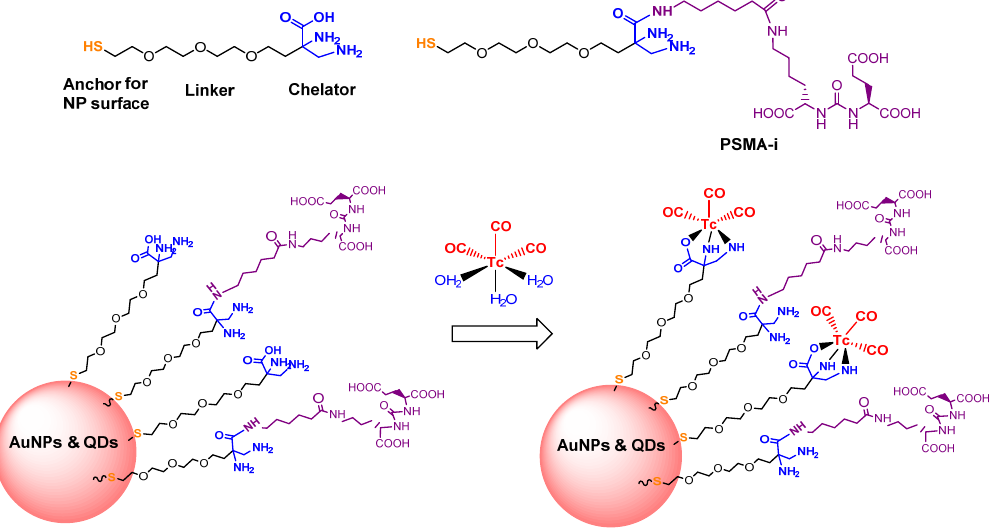
Figure 10. Coating ligands and radiolabeled PSMA-i derivatized NPs designed by Felber and